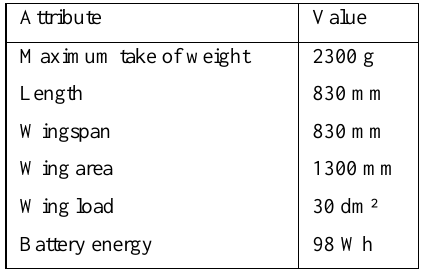
Table 1. Overview of the major technical specifications of the